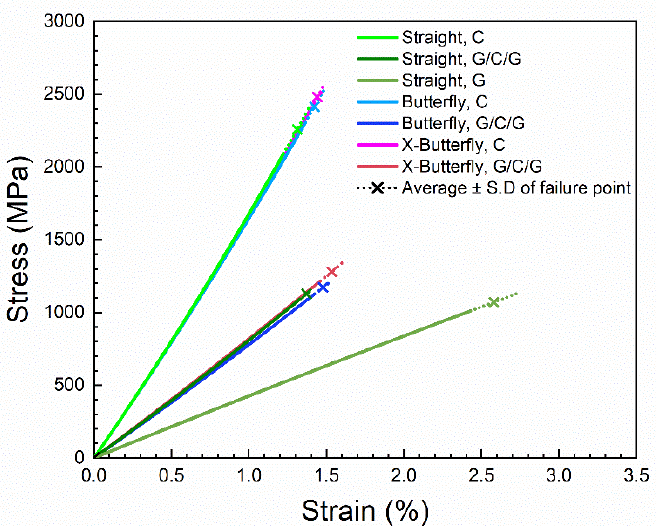
Figure 10. The seven groups of fitted stress–strain